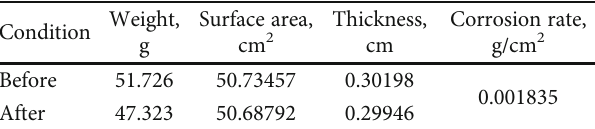
Figure 7: Results of precipitation tendency for dissolved solids for the two scale samples. Condition